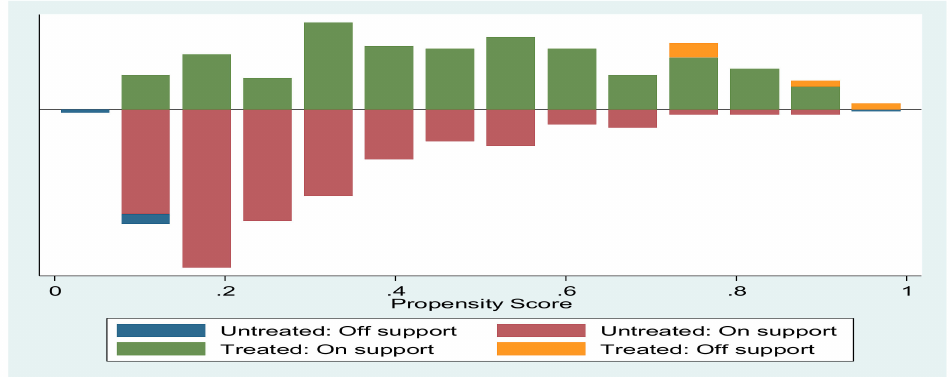
Figure 2. Common support graphical